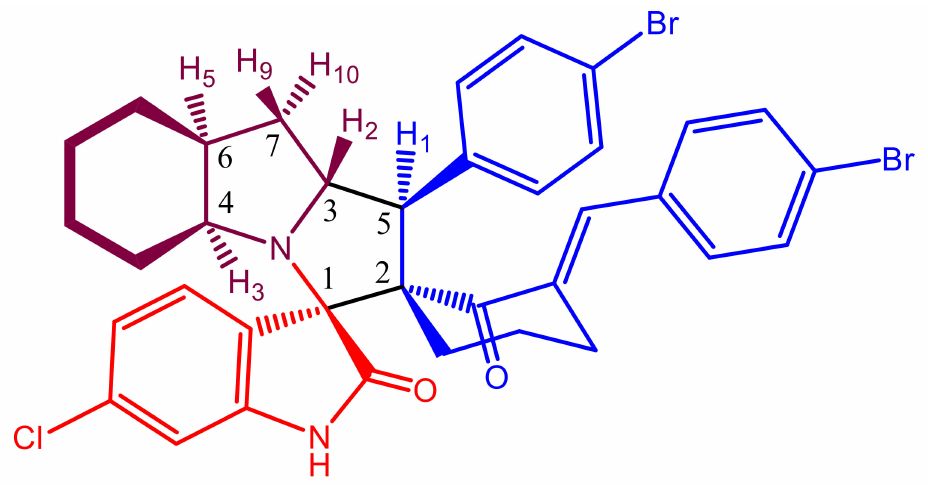
Figure 2. Chemical structure of 4f